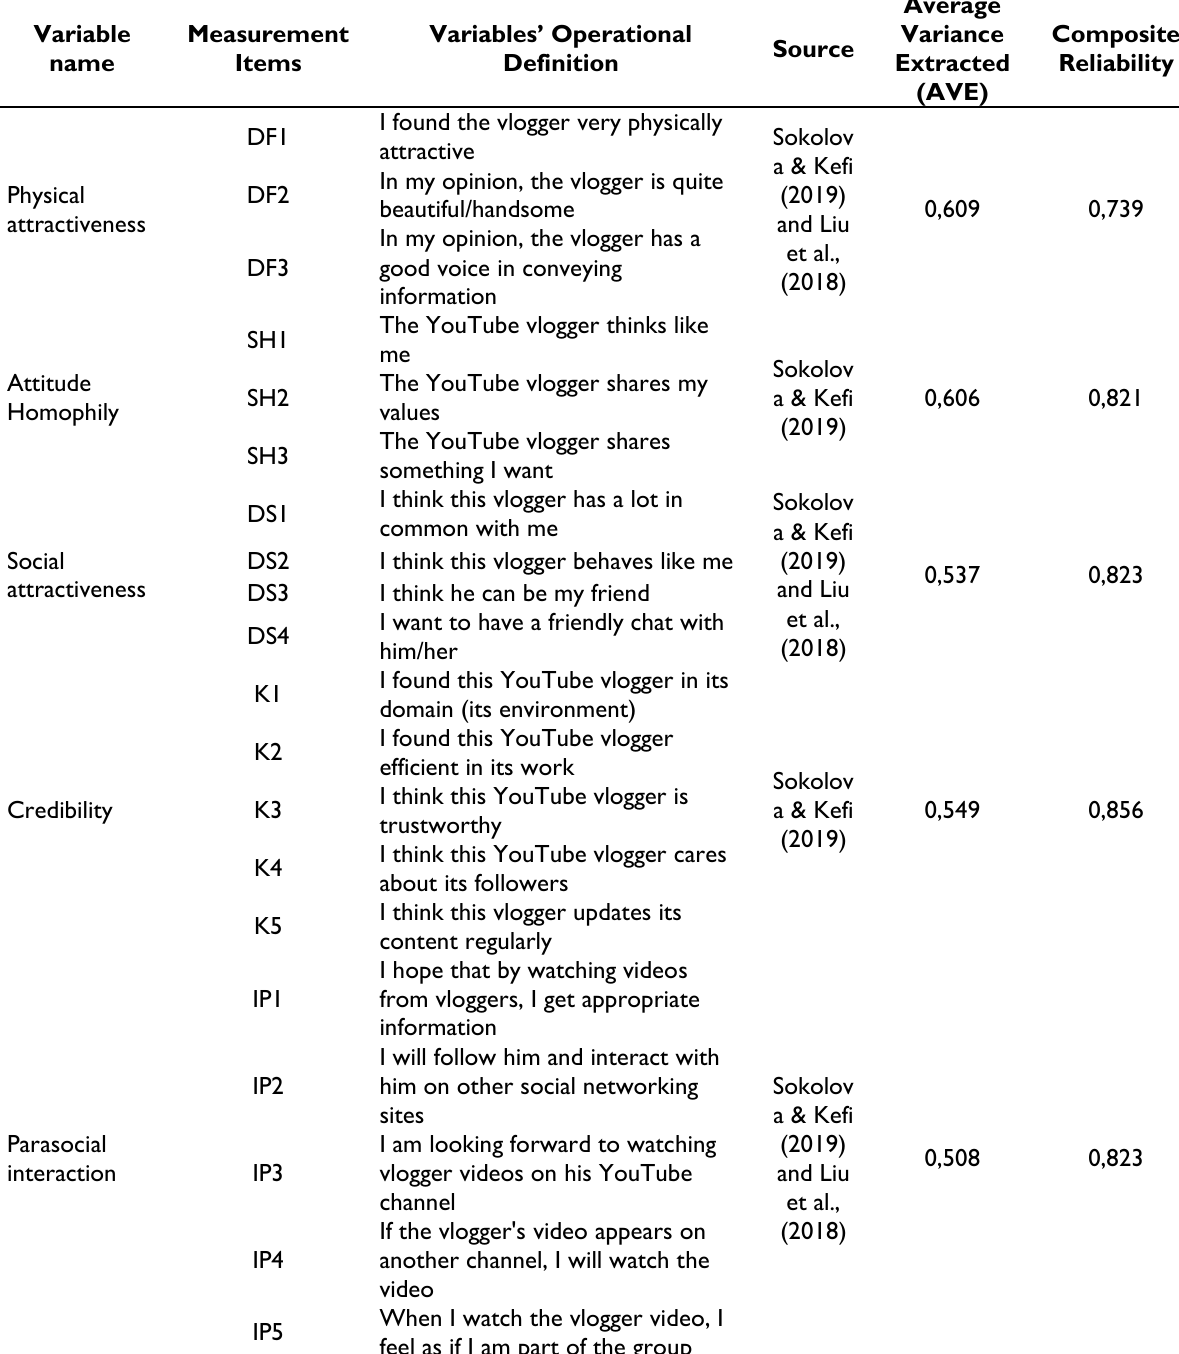
Table 1. Operational Definition of Variables